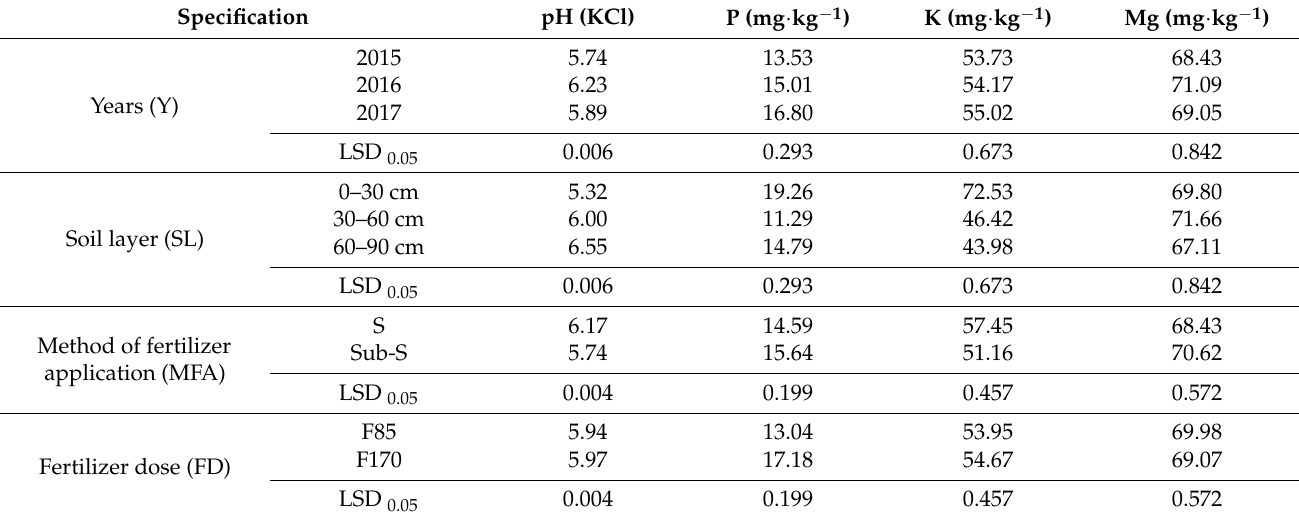
Table 6. Evaluation of the pH and soil content of available forms of selected macronutrients after soybean harvest.